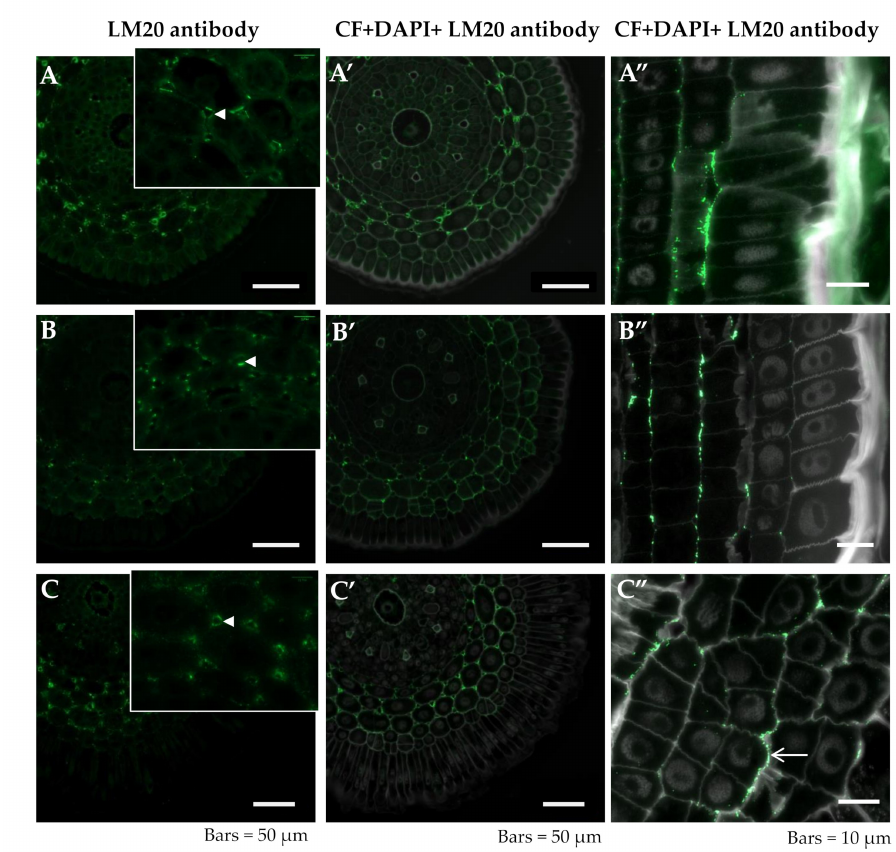
Figure 5. Distribution of LM20 epitope in cross sections in di ff erentiated zone ( A , A’ – C,C’ ) and longitudinal sections in the meristematic zone ( A” – C” ) of root tissues of barley cv. Sebastian. ( A – A” )—control pH 6; ( B – B” )—control pH 4; ( C – C” )—30 µ M AlCl 3 . ( A – C ) insets—higher magnification of cortex cells with developing intercellular spaces. Detection of LM20 epitope ( A – C ), Calcofluor (CF), and DAPI staining with immunolocalization of LM20 epitope ( A’ – C’ , A” – C” ) are shown. ( A – C )—arrowheads within insets show developing intercellular spaces with LM20 epitope recognized. C”—arrow shows the LM20 signal in the outer wall of cell from the complex arising from the cortex “mother” cell division. Epitope distribution in representative sections are